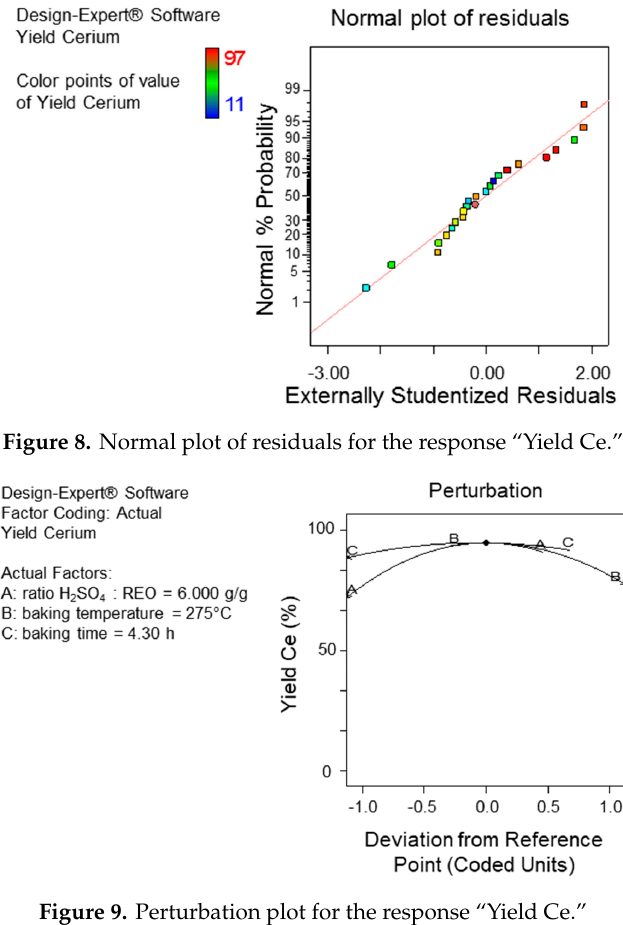
Figure 9. Perturbation plot for the response “Yield Ce.”